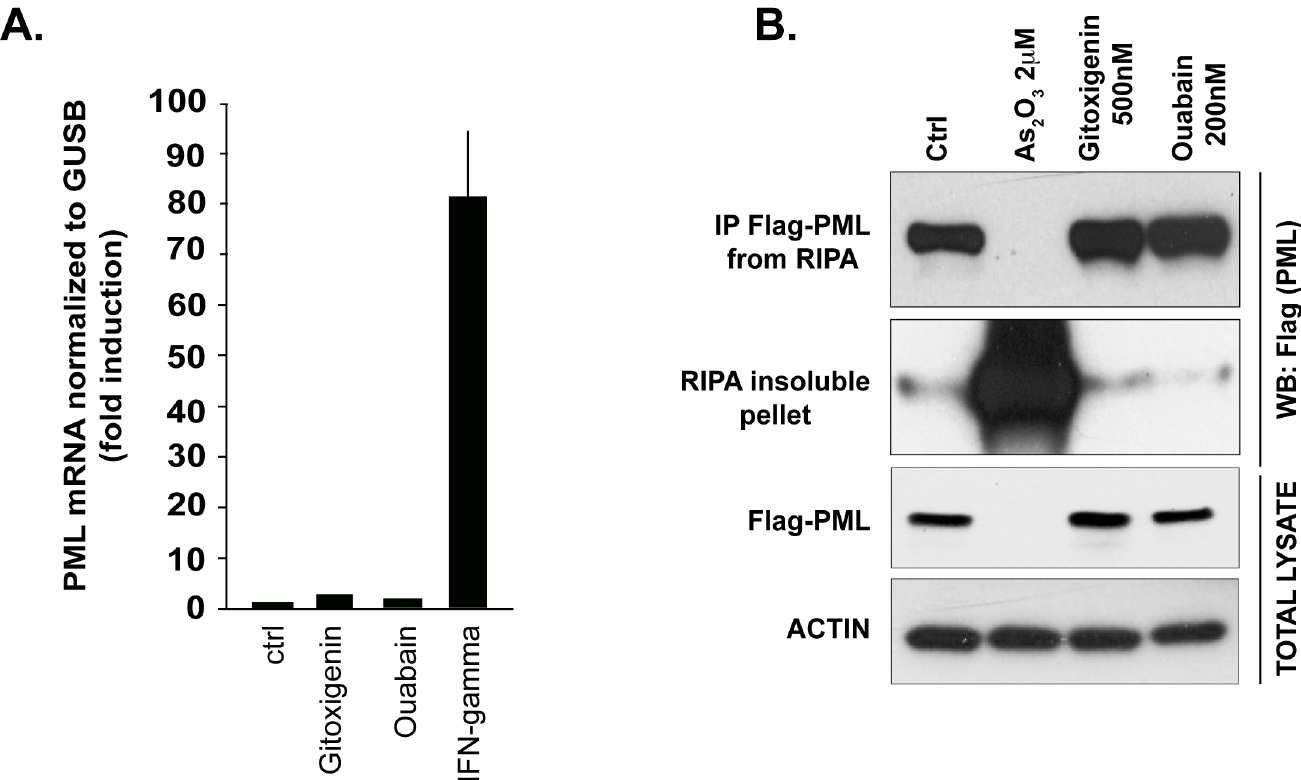
Fig 3. CGs do not induce PML expression or association with nuclear matrix. A, HeLa cells were dispensed into 384-well pates at a density of 2000 cells/wells. The next day the cells were incubated with 2 μ M gitoxigenin, 200 nM ouabain and 16 u IFN U for 18h. RNA was isolated and RT-qPCR was performed for PML and GUSB. PML expression was normalized to GUSB internal control. Error bars are SEMs of 6 replicates. B, HEK293T were transfected with Flag-PML IV. The next day the cells were treated as indicated for 24h, followed by lysis in RIPA buffer and centrifugation. RIPA supernatants were immunoprecipitated using anti-Flag antibody. The total lysates before immunoprecipitation, the immunoprecipitated complexes and the RIPA-insoluble pellets were separated on SDS-PAGE followed by immunoblotting with anti-Flag (PML) or anti-ACTIN antibody.